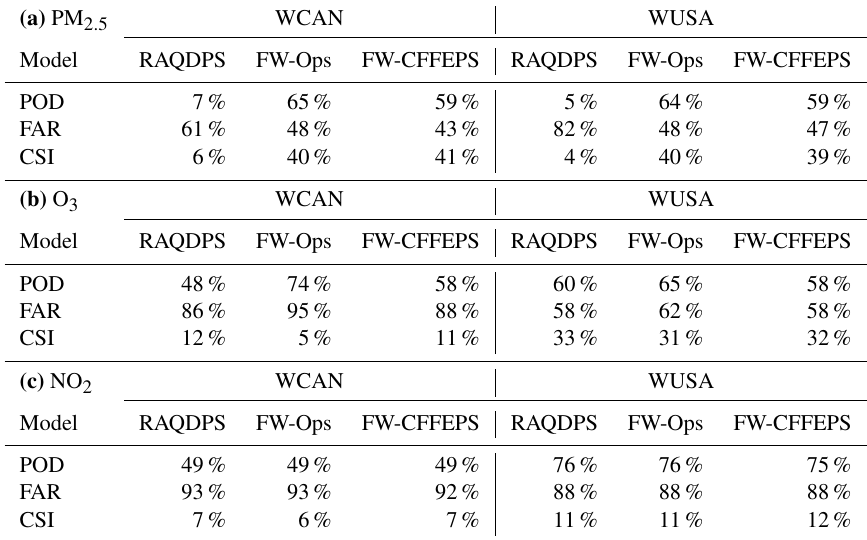
Table 7. Categorical scores for July–September 2017 by geographic region for hourly (a) PM 2 . 5 events or exceedances based on a threshold of 30µgm − 3 , (b) O 3 events based on a threshold of 65ppbv, and (c) NO 2 events based on a threshold of 30ppbv.